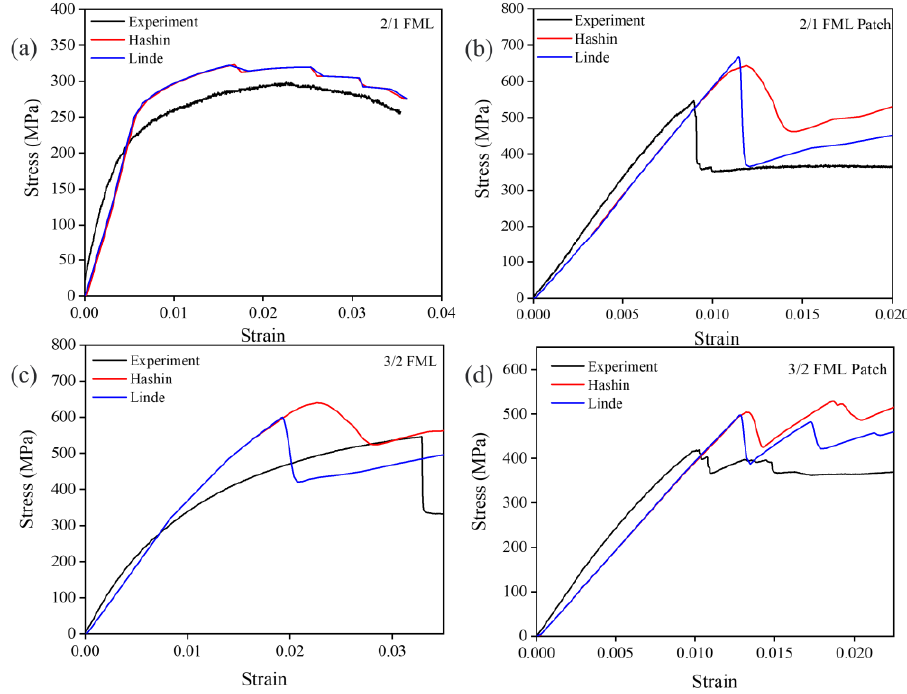
Figure 5. Flexural stress-strain curves of FMLs with different stack structures ( a ) 2/1 FMLs, ( b ) 3/2 FMLs patch, ( c ) 3/2 FMLs, ( d ) 3/2 FMLs patch.